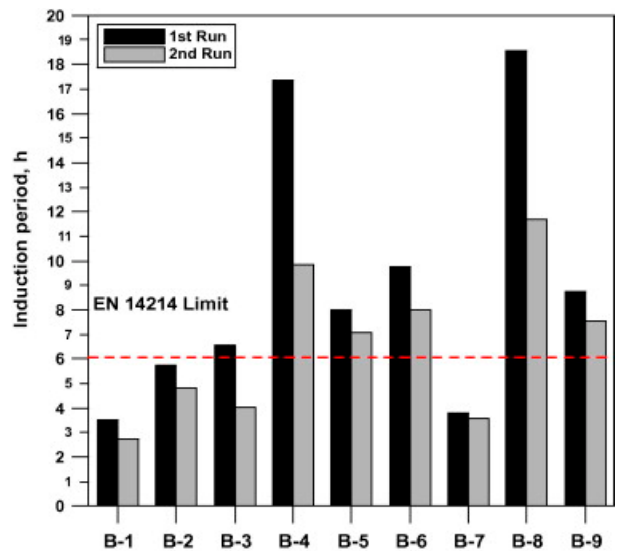
Figure 19. The changes recorded on the oxidation stability of the nine biodiesel samples [142].